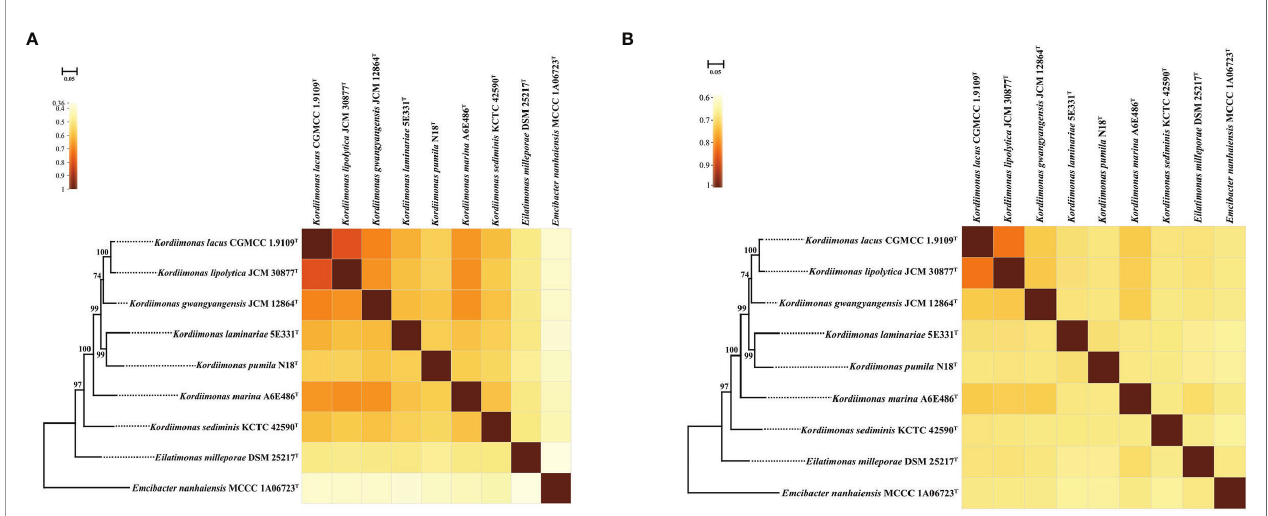
FIGURE 2 | Heat maps showing POCP and ANI values among A6E486 T , 5E331 T , and members of the family Temperatibacteraceae . (A) Heat map based on POCP values. (B) Heat map based on ANI values. IQ-TREE based on ribosomal protein sequences shows the phylogenetic relationships among these strains. Percentage bootstrap values (1,000 replicates) are shown at branch nodes. Emcibacter nanhaiensis MCCC 1A06723 T was used as the out-group. Bar, 0.05 substitutions per nucleotide position. Same tree topology was also obtained using FastTree. ANI, average nucleotide identity; POCP, percentage of conserved